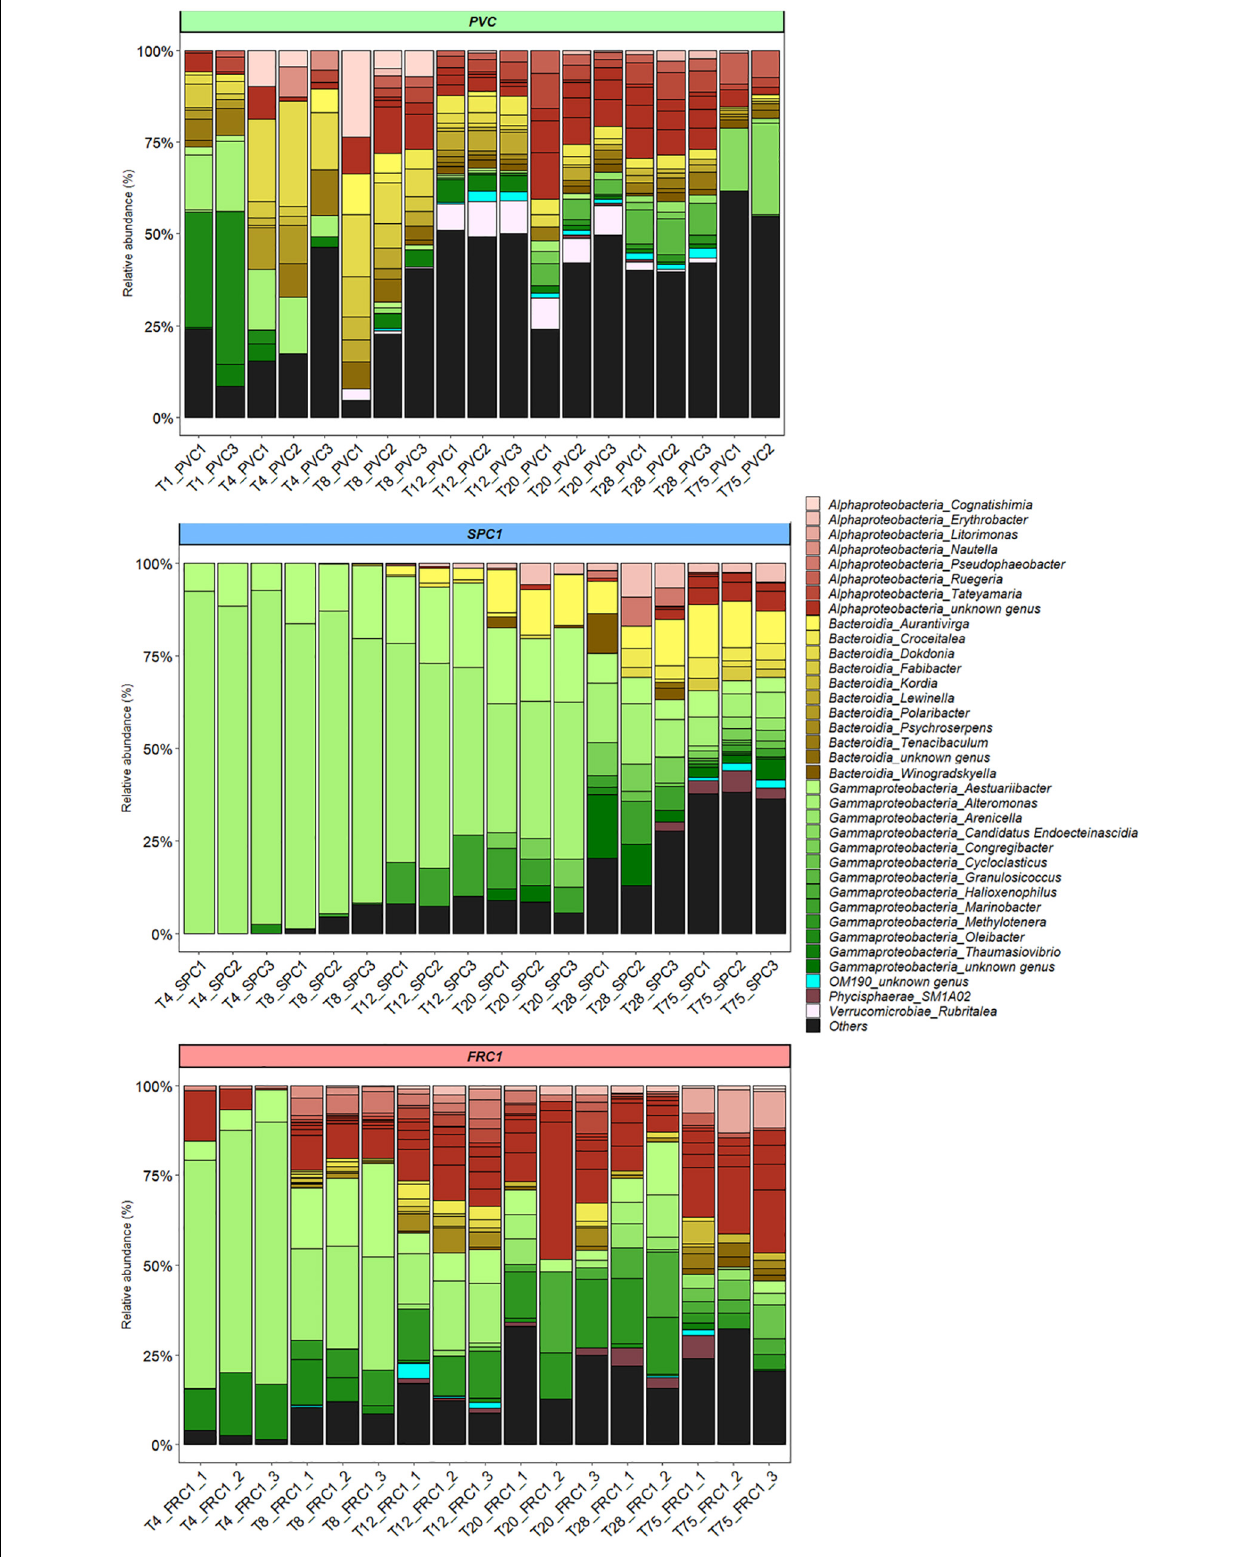
FIGURE 4 | Dynamics of the relative abundance of the bacterial genera from T1 to T75 for PVC, SPC1, and FRC1 (including replicates) at Toulon. Others corresponded to genera with a relative abundance lower than 0.5%.